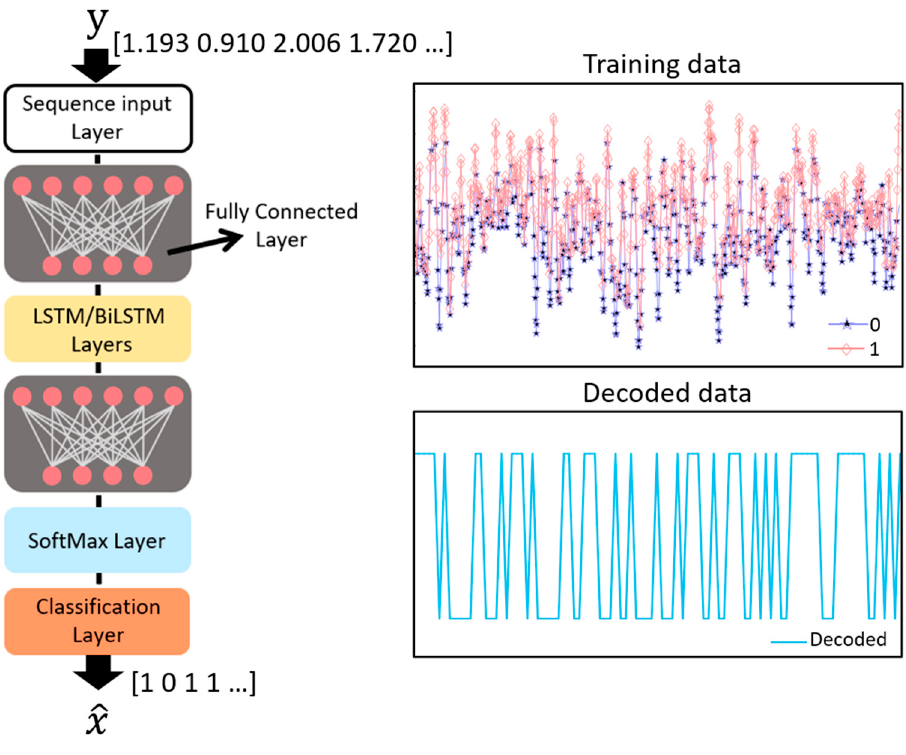
Figure 8. Diagram of the proposed neural network. Table 1. The training options and the hyperparameters’ values.